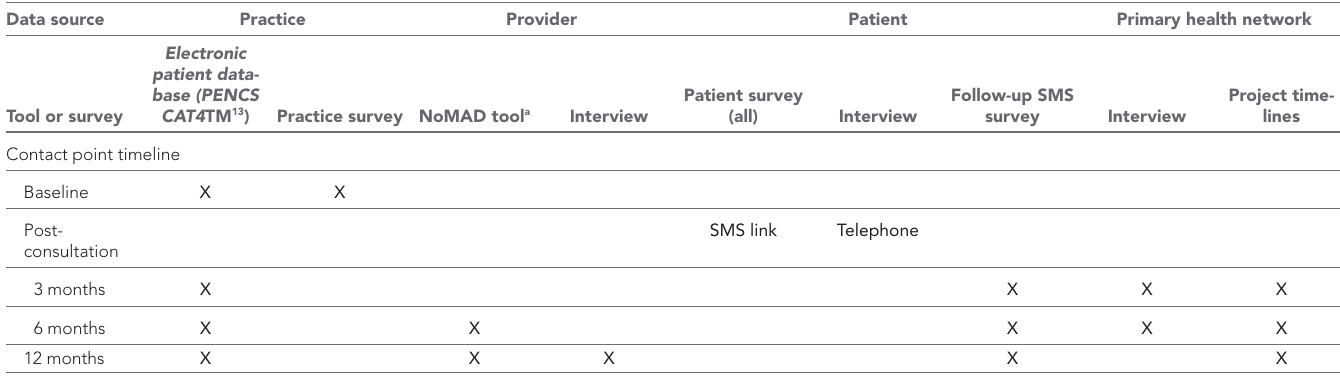
Table 1 Data Source and data collection